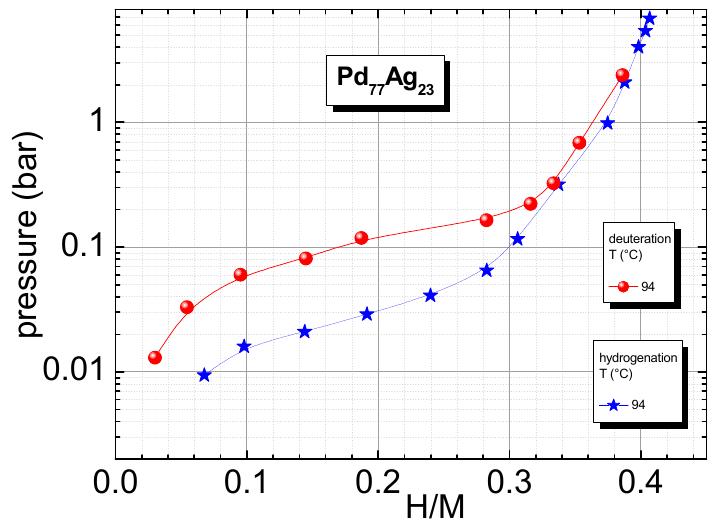
Figure 7. Comparison of the pressure-composition isotherm of Pd 77 Ag 23 at 94 °C for hydrogen and deuterium absorption.